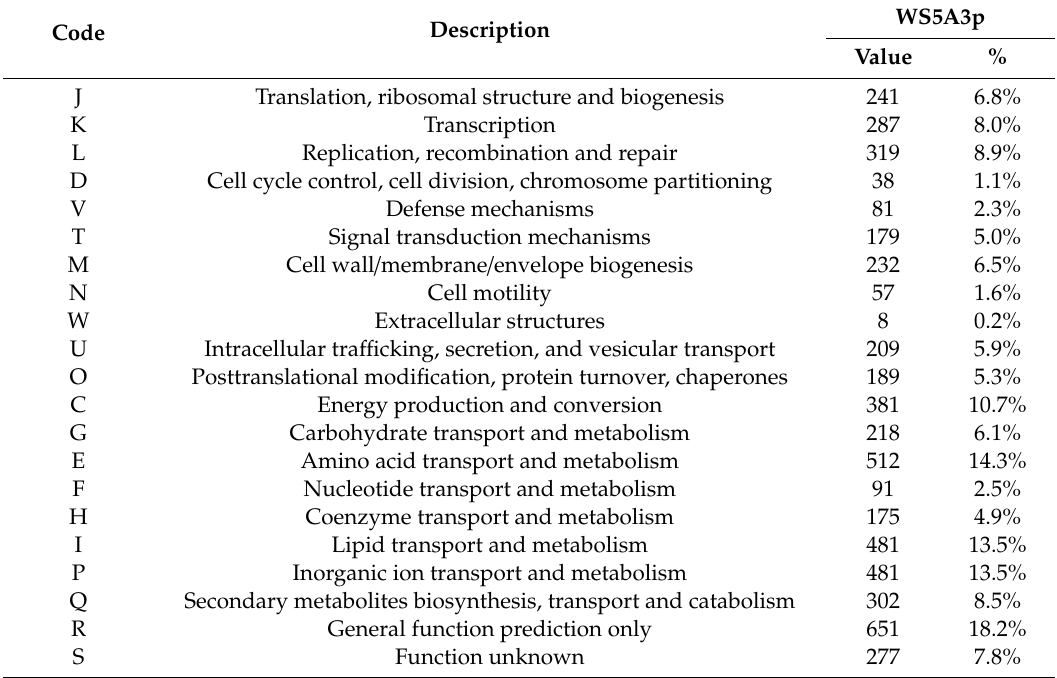
Table 1. Gene counts associated with the general COGs (clusters of orthologous groups) functional categories for the genome of Sphingopyxis lindanitolerans WS5A3p, obtained from COGNIZER software